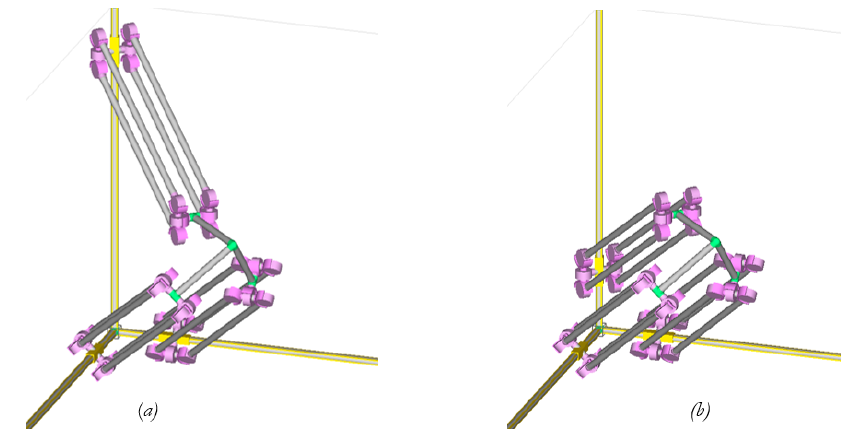
Figure 12. Singular posture. Two and three legs in the same direction